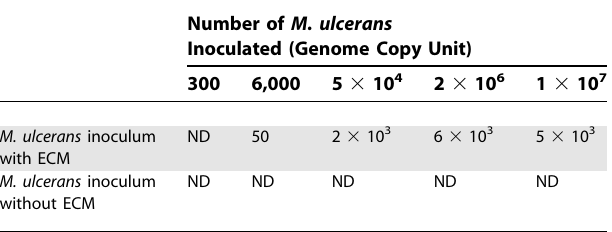
Table 2. Detection of M. ulcerans DNA Isolated from Naucoris Insect after Infection by Grub Containing M. ulcerans with or without ECM